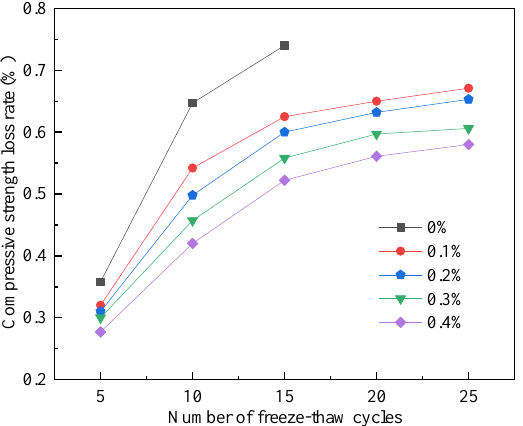
Figure 26. Compressive strength loss rate of freeze – thaw cycle test.